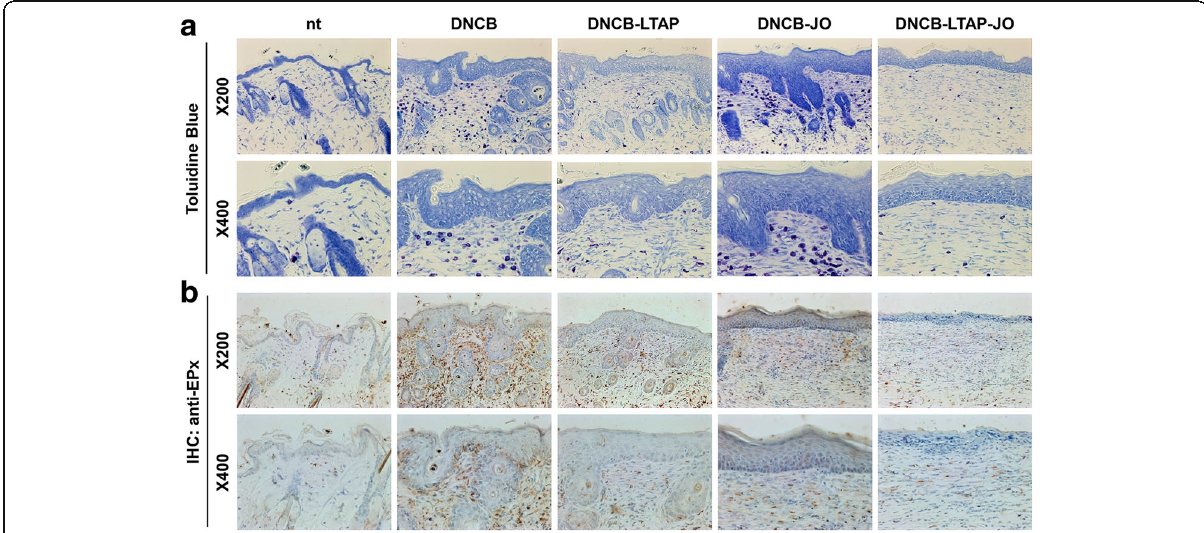
Fig. 4 The effects of LTAP-JO treatment on DNCB-mediated accumulation of mast cell and eosinophil in the skin. a The result of toluidine blue staining of the skin tissues of mice from each group. The mast cells are shown as dark-purple dots in the dermis. b The result of the immunohistochemistry assay against eosinophilic peroxidase (EPX). Eosinophils are shown as stained cells in brown. The nuclei of the cells in skin tissues are counterstained with hematoxylin. Data shown are representatives of each group of mice ( n = 5)